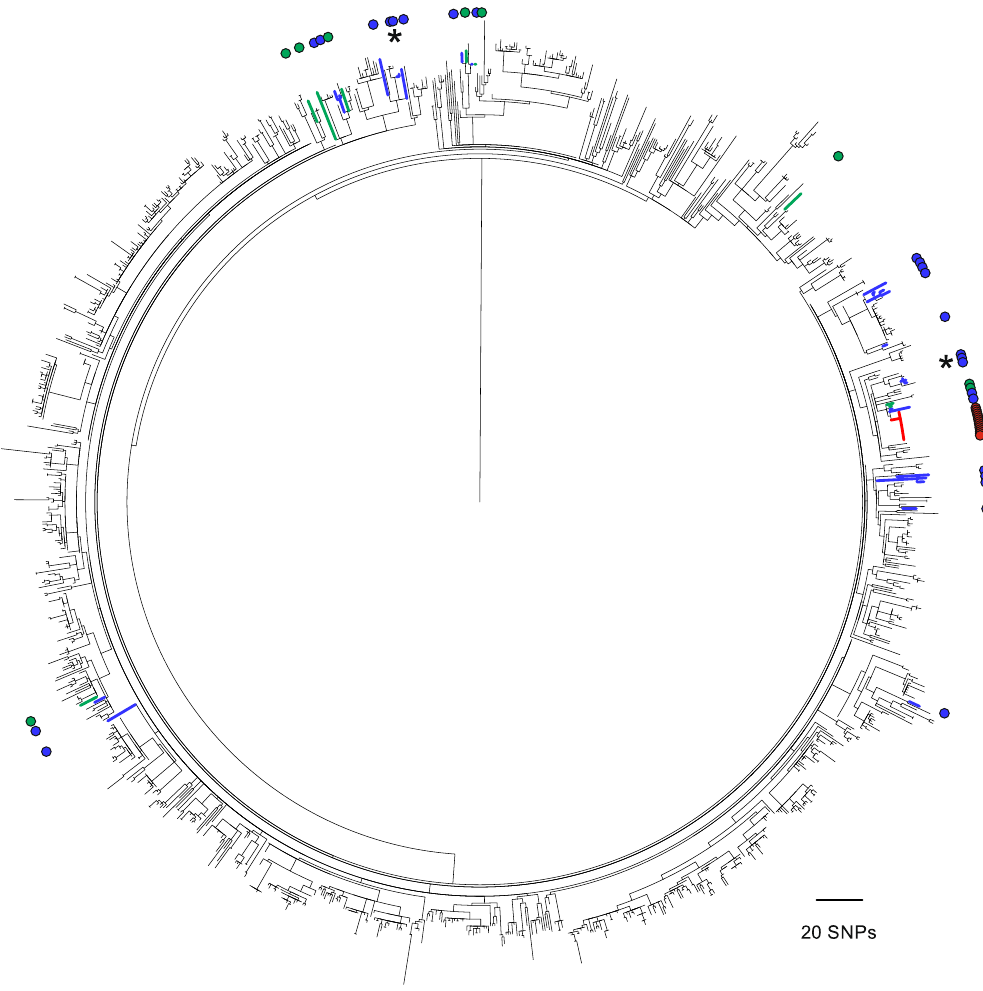
Figure 3. Global context of emm 1 and outbreak identification. A maximum-likelihood phylogenetic tree was constructed using core genome SNPs (excluding prophages) identified in 1259 sequenced emm 1 strains isolated 2005–2013 from USA (n = 381), Canada (n = 23), Denmark (n = 269), Finland (n = 204), Norway (n = 54), Iceland (n = 16), Sweden (n = 263) 3 and the UK (n = 49) 14 compared to MGAS5005. The UK isolates are identified by coloured branches and highlighted by coloured circles around the outside of the tree. They comprise 25 from the study collection (blue branches and circles), plus 9 from various locations in the UK (green branches and circles) and 15 emm 1 outbreak isolates (red branches and circles) from a previous study 14 . Although the majority of UK isolates are dispersed across the tree, those associated with the outbreak and the two study local clusters (indicated by * ) are clearly distinct from other emm 1